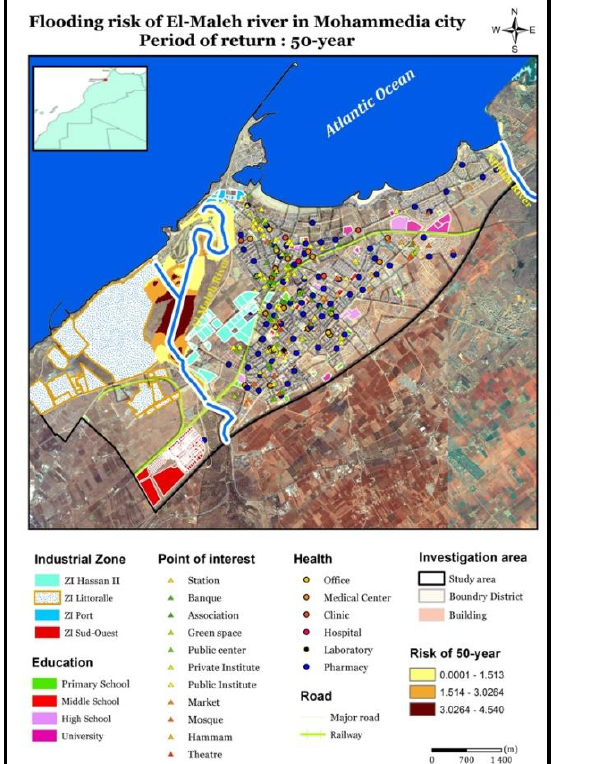
Figure 9. Flooding risk of a 50-year